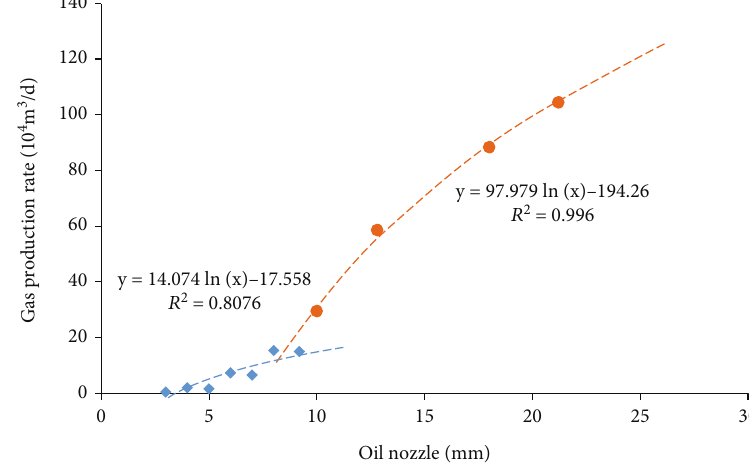
Figure 6: Correlation between gas well production rate and oil nozzle. Table 4: Comparison between measured and predicted gas production